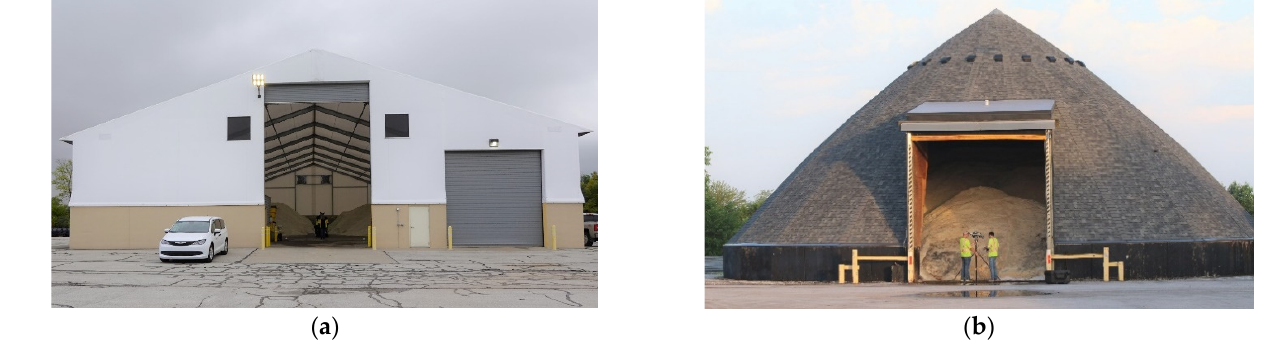
Figure 1. Samples of salt storage facilities: ( a ) rectangular barn and ( b ) dome.